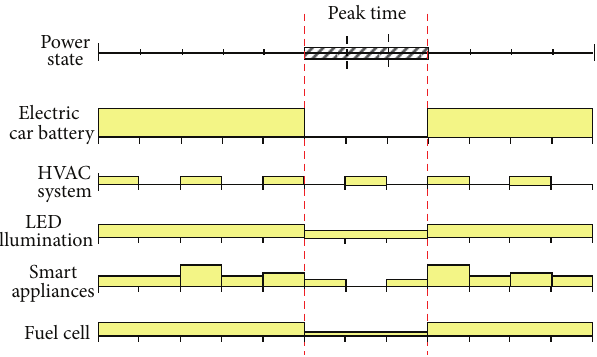
Figure 2: An example of electricity usage scheduling.